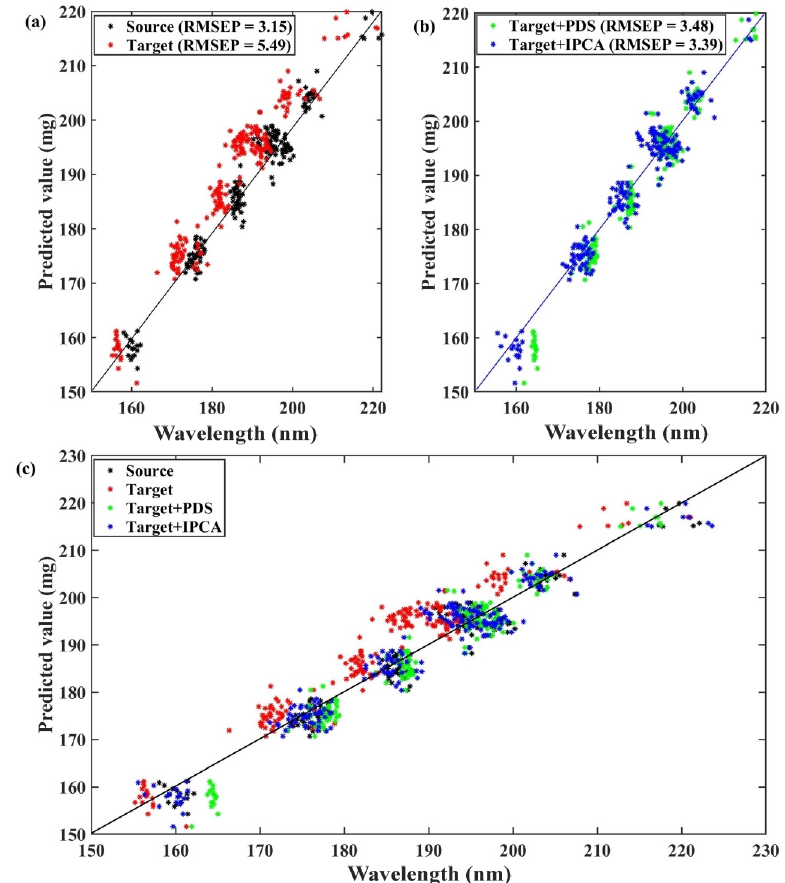
Figure 4. Relationship of reference and predicted API value in validation set obtained by ( a ) source and target spectra, ( b ) transferred spectra with PDS and IPCA, and ( c ) all of them, respectively.